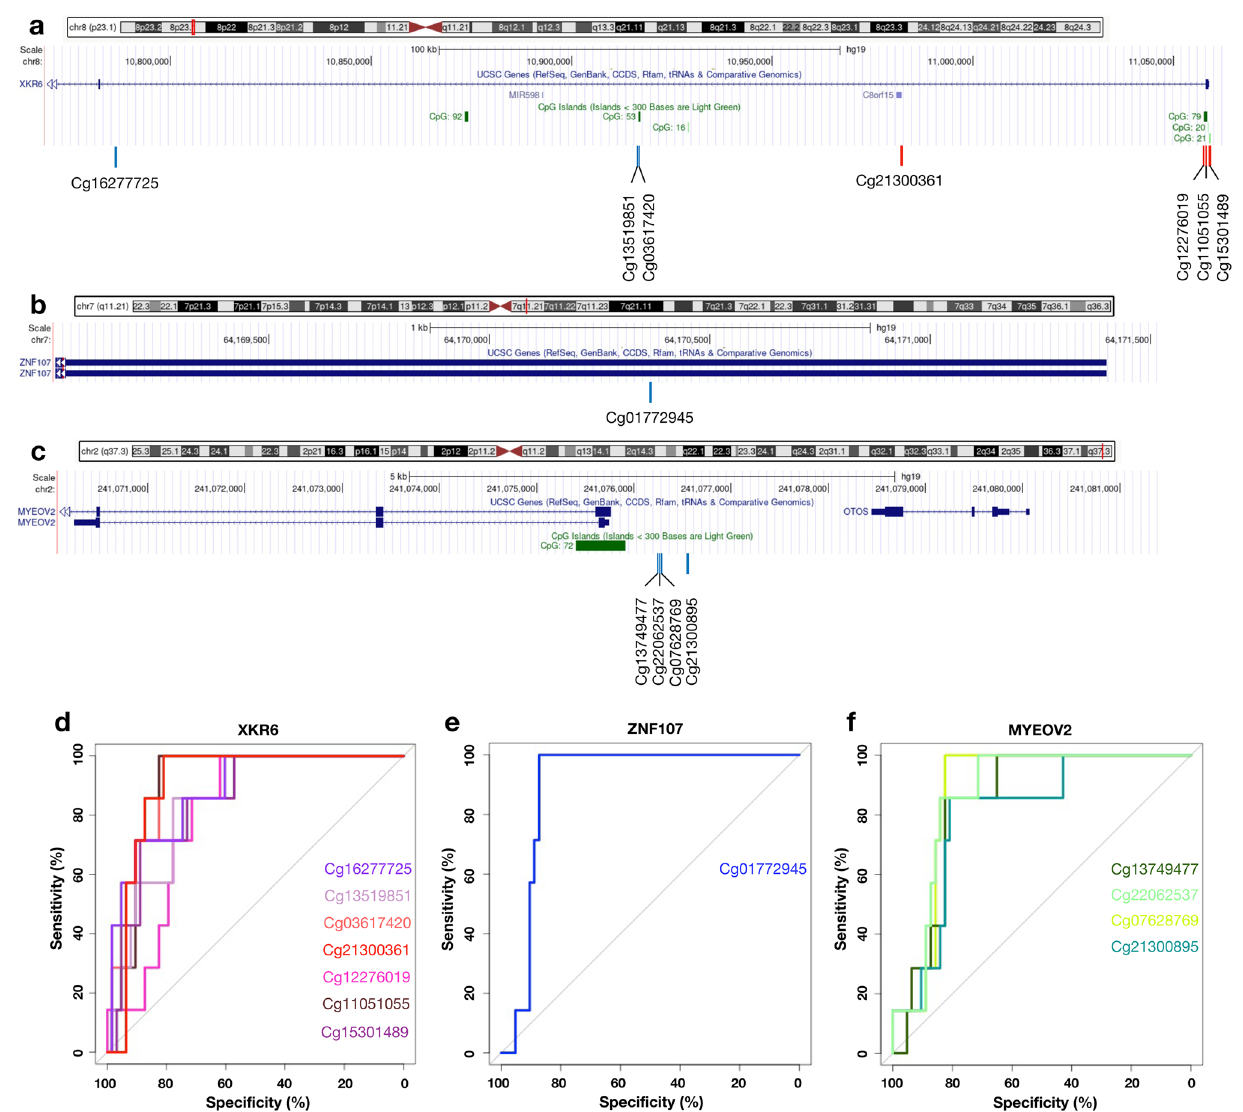
Figure 4. Genomic location and specificity of the unique differentially methylated regions in ASD with 16p11.2 deletion. Genomic location on XK related 6 (XKR6) ( a ), Zinc Finger Protein 107 (ZNF107) ( b ) and Myeloma overexpressed 2 (MYEOV2) ( c ): blue line represents hypomethylation, red line represents hypermethylation. The receiver operating characteristic (ROC) analysis of the unique differentially methylated regions of ASD with 16p11.2 deletion (n = 7) was performed against non-ASD (n = 48) and ASD with CHD8 variants (n = 15). Specificity and sensitivity of the unique differentially methylated regions for XKR6 ( d ), ZNF107 (e) and MYEOV2 ( f